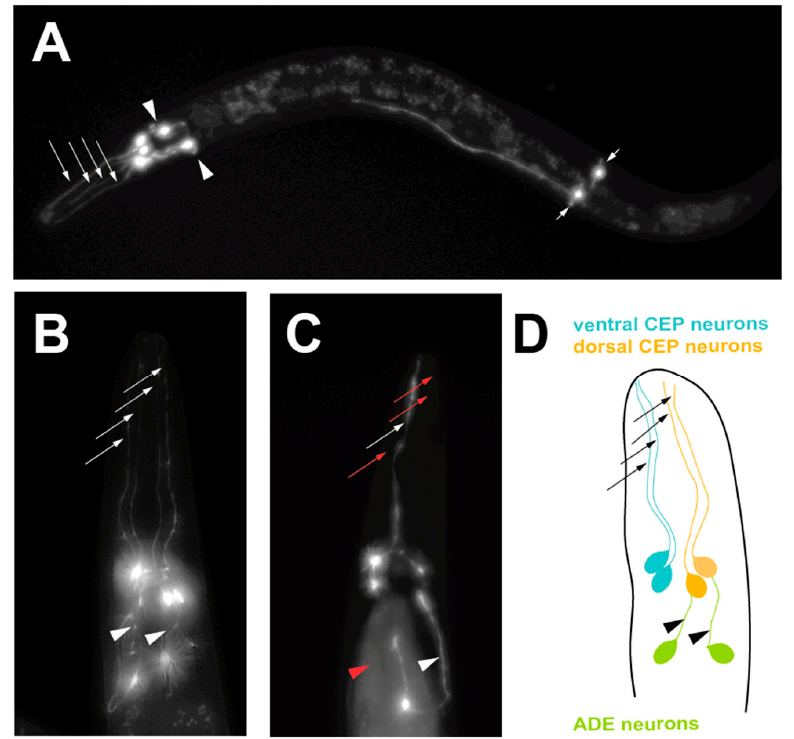
Figure 2. A progressive, age-dependent C. elegans α -syn model of PD [18]. ( A ) A worm expressing solely Green Fluorescent Protein (GFP) in the 8 DA neurons, with GFP being driven under the dopamine neuron-specific dat-1 promoter for visualization. Arrows with long tails indicate the 4 CEP neuron processes, arrowheads indicate the 2 ADE neuron processes and arrows with short tails indicate the 2 PDE neuron processes. ( B ) A worm expressing both GFP and human, wild-type α -syn in the DA neurons being driven under the dopamine neuron-specific dat-1 promoter, allowing visualization of the 6 DA neurons located in the head region. Arrows indicate non-degenerated CEP neuron processes and arrowheads indicate non-degenerated ADE neuron processes. ( C ) A worm expressing both GFP and human, wild-type α -syn in the DA neurons being driven under the dat-1 promoter, allowing visualization of the 6 DA neurons located in the head region. Red arrows indicate degenerated CEP neuron processes and the red arrowhead represents a degenerated ADE neuron process. ( D ) A representation of the neuroanatomy of the 6 DA neurons in the head region of C. elegans . Ventral and dorsal CEP neurons are shown, along with the ADE neurons. A protein involved in lysosomal trafficking, VPS-41, was found to modulate α -syn misfolding and/or clearance in worms. Furthermore, its ability to modulate DA neuron degeneration induced by α -syn overexpression was determined using this C. elegans model of PD [27]. The overexpression of the human vps-41 gene not only prevented DA neuron loss in this model but it also decreased levels of α -syn in human neuroglioma cells [35]. In addition, two specific domains residing on the VPS-41 protein, the AP-3 and clathrin heavy-chain repeat domains, were shown to be required for neuroprotection [36]. Not only can VPS-41 protect dopamine neurons from succumbing to the stress of α -syn accumulation in vivo , it also protects glutamatergic neurons—the major neuron subtype affected in Alzheimer’s disease—from succumbing to the stress associated with amyloid beta (A β ) neurotoxicity [37]. These collective data support the potential for the use of vps-41 as a prospective candidate for gene therapy.